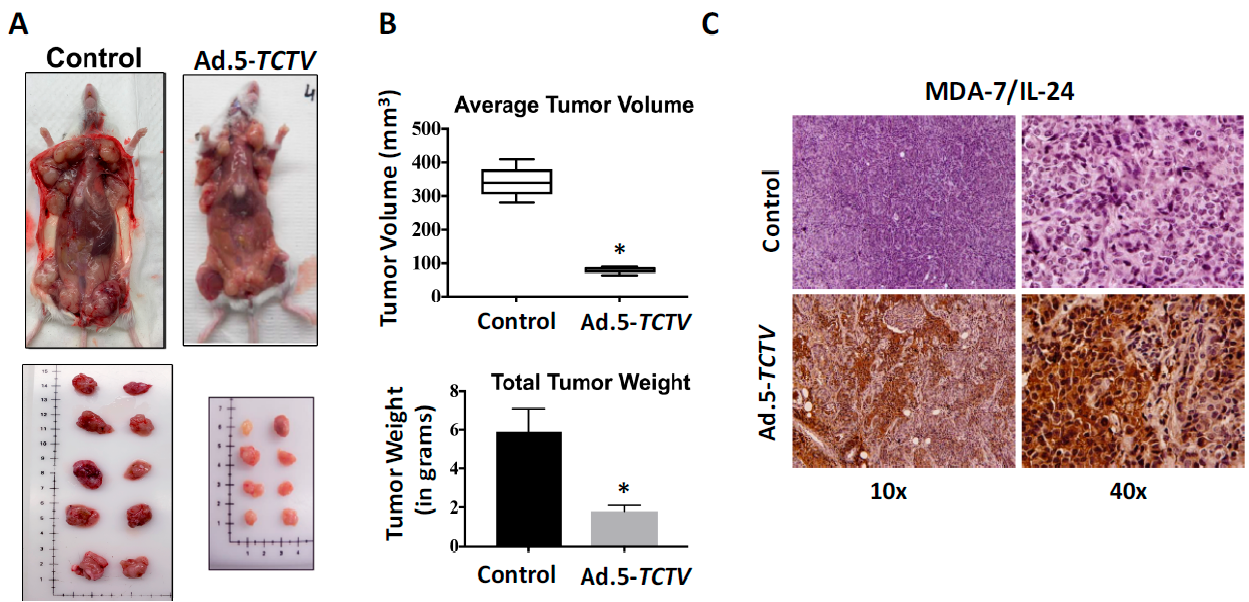
Figure 6. Ad.5- TCTV inhibits tumor growth in the MMTV-PyMT model. Mice treated intratumorally with Ad.5- CTV as described in methods or untreated controls were monitored for tumor burden over 4-weeks following first appearance of tumors. ( A ) Shown are representative photographs of tumors present in MMTV-PyMT mice untreated or treated with Ad.5- TCTV at the time of euthanasia. In each of the images, image dimensions are adjusted roughly to match the scale. ( B ) Tumor volumes and weights were quantified and the average tumor volume and total tumor weight are presented in a graphical manner. * p < 0.05 vs. control. ( C ) Immunohistochemical analysis of MDA-7/IL-24 in control and Ad.5- TCTV treated tumor sections.